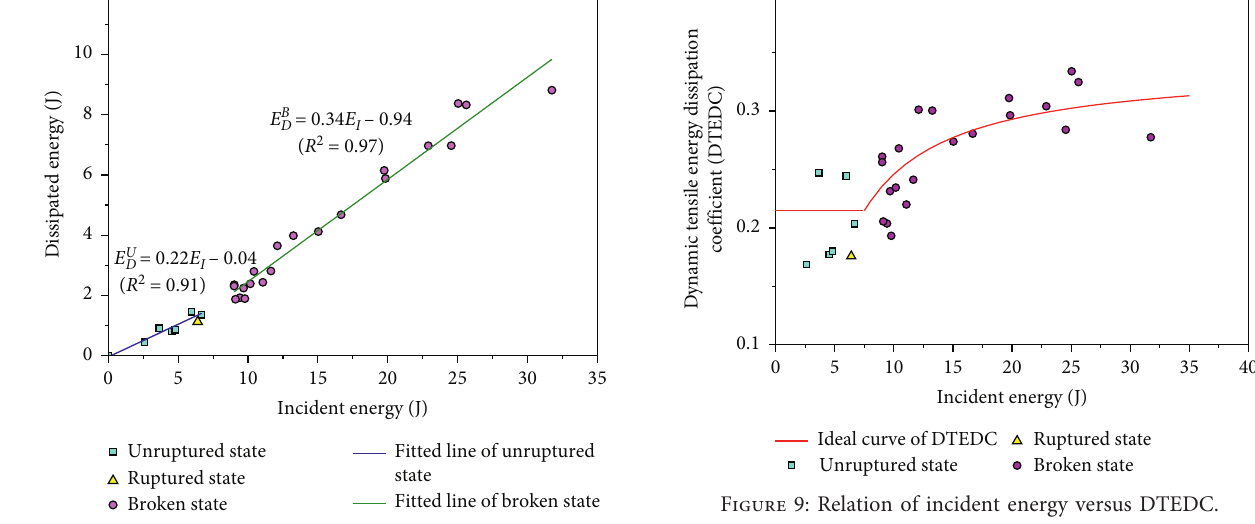
Figure 8: Fitted lines of the dissipated energy-incident energy in the “ U ” state and “ B ” state (“ U ” state is the unruptured state and “ B ” state is the broken state).